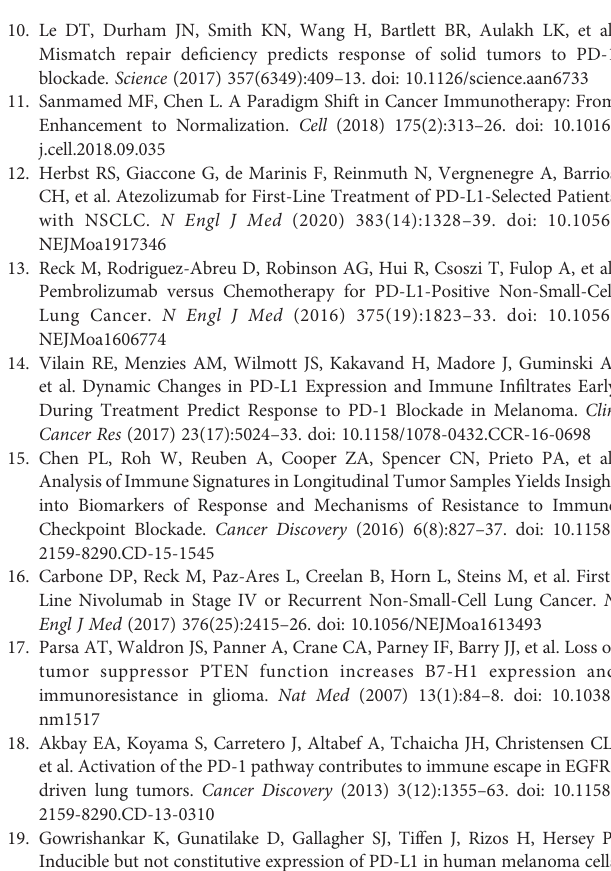
external reference for the quantitative detection of mRNA in plasma. CT, cycle threshold. Supplementary Figure 2 | The differences of tPD-L1 and bPD-L1 between subgroups in 33 NSCLC patients. (A) Comparison of PD-L1 mRNA expression between subgroups. (B) Comparison of sPD-L1 expression between subgroups. (C) Comparison of tPD-L1 expression between subgroups. tPD-L1, tissue PD-L1; bPD-L1, blood PD-L1; NSCLC, non-small cell lung cancer; sPD-L1, soluble PD-L1. P values were calculated by independent-samples t-test (A, B) and Pearson ’ s chi- square test or Fisher ’ s exact test (C) . Supplementary Figure 3 | The correlation of tPD-L1 and bPD-L1 in 51 patients with various malignancies. (A) The correlation of PD-L1 mRNA and tPD-L1. (B) The correlation of sPD-L1 and tPD-L1. tPD-L1, tissue PD-L1; bPD-L1, blood PD-L1; sPD-L1, soluble PD-L1; NSCLC, non-small-cell lung cancer. P values were calculated by independent-samples t-test. Supplementary Figure 4 | The differences of tPD-L1 and bPD-L1 between subgroups in 51 patients with various malignancies. (A) Comparison of PD-L1 mRNA expression between subgroups. (B) Comparison of sPD-L1 expression between subgroups. (C) Comparison of tPD-L1 expression between subgroups. tPD-L1, tissue PD-L1; bPD-L1, blood PD-L1; sPD-L1, soluble PD-L1. P values were calculated by independent-samples t-test (A, B) and Pearson ’ s chi-square test or Fisher ’ s exact test (C) . Supplementary Figure 5 | Veri fi cation of exosomes. (A) Exosome morphology detected by TEM. (B) Positive markers (CD9, CD63) and a negative marker (calnexin) of exosomes detected by WB. (C) Size analysis of exosomes through NTA. TEM, transmission electron microscopy; WB, western blotting; NTA, nanosight tracking